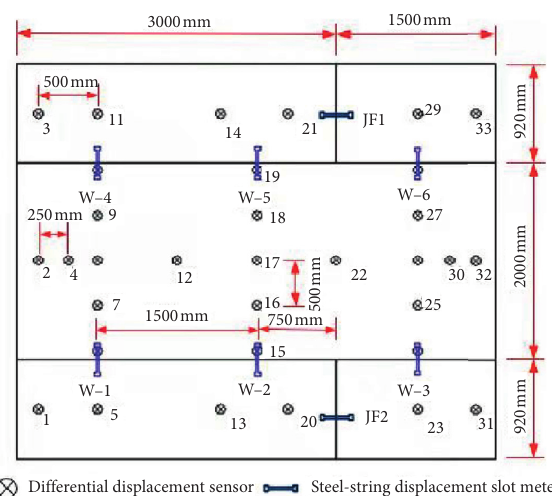
Figure 5: Layout of the measured points.